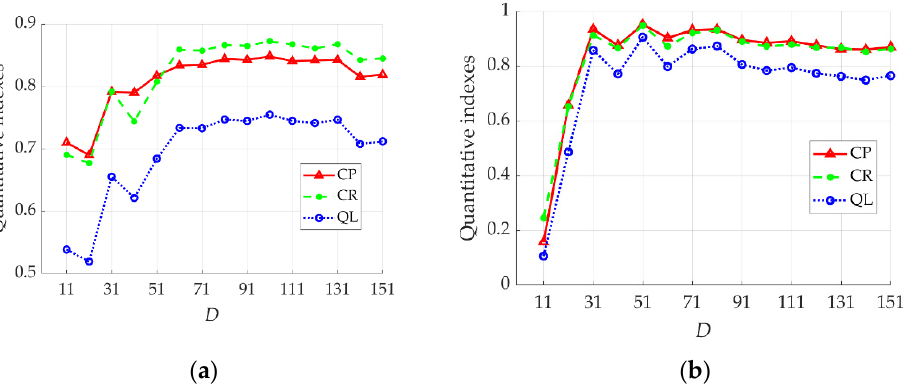
Figure 15. The quantitative indexes ( CP , CR , QL ) versus the diameter D of the sliding window. ( a ) Results for test image 2. ( b ) Results for test image 6.